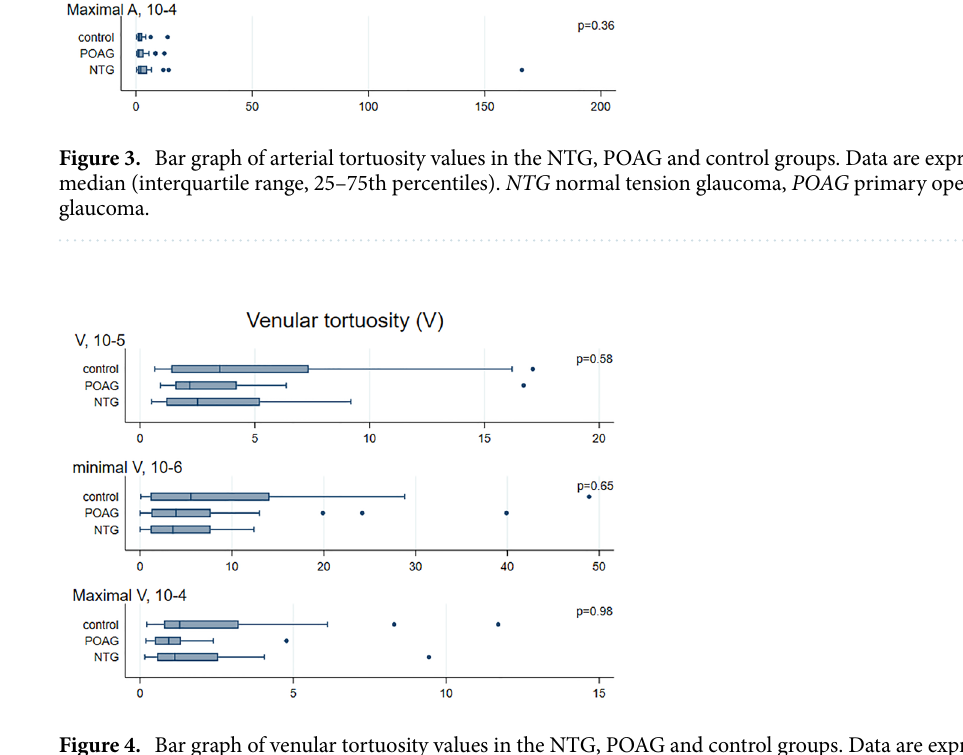
Figure 4. Bar graph of venular tortuosity values in the NTG, POAG and control groups. Data are expressed as median (interquartile range, 25–75th percentiles). NTG normal tension glaucoma, POAG primary open angle